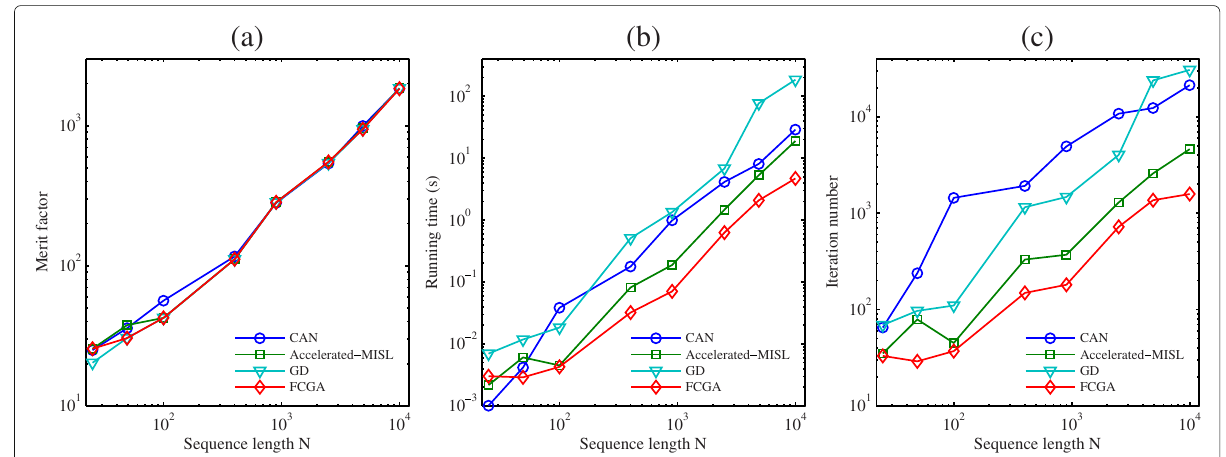
Fig. 7 a – c The performance metrics of different algorithms initialized by Golomb